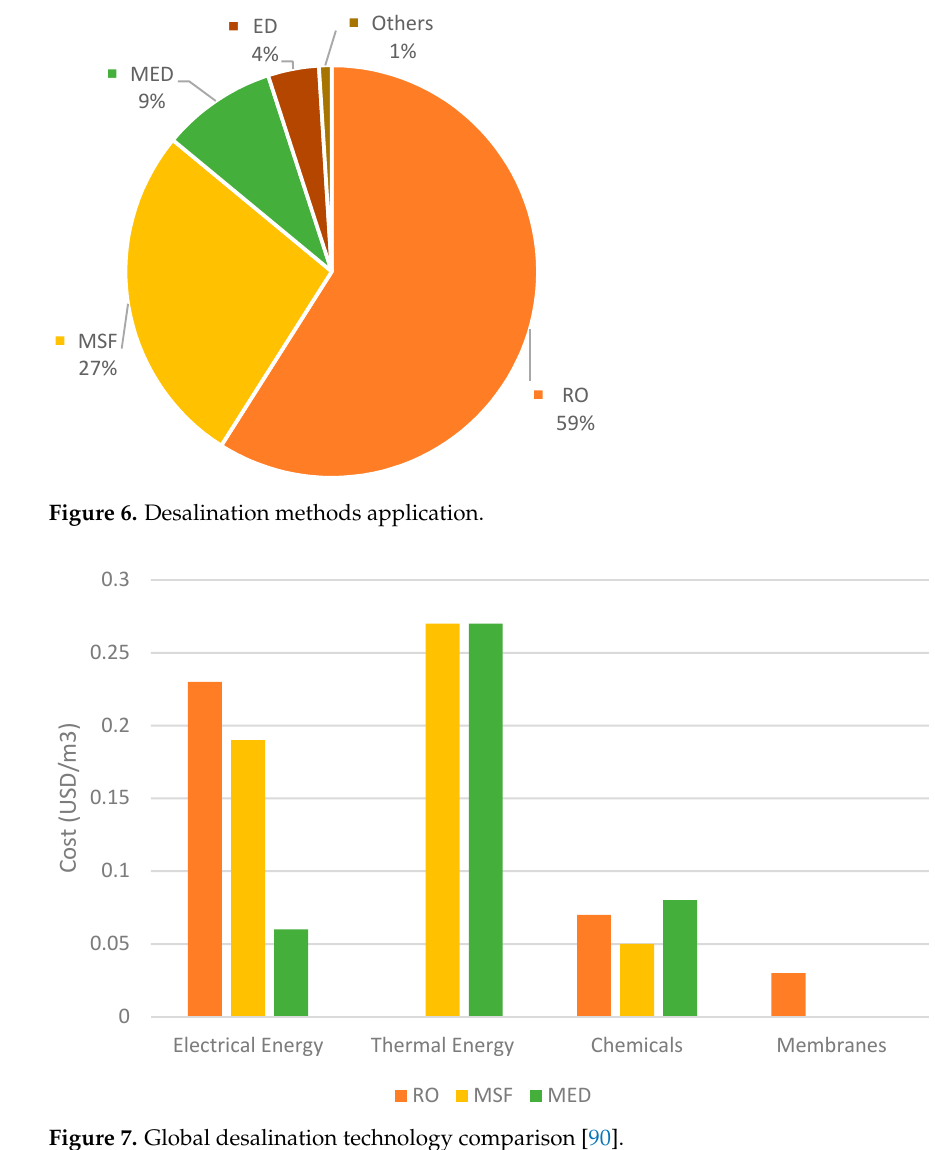
Figure 7. Global desalination technology comparison [90].